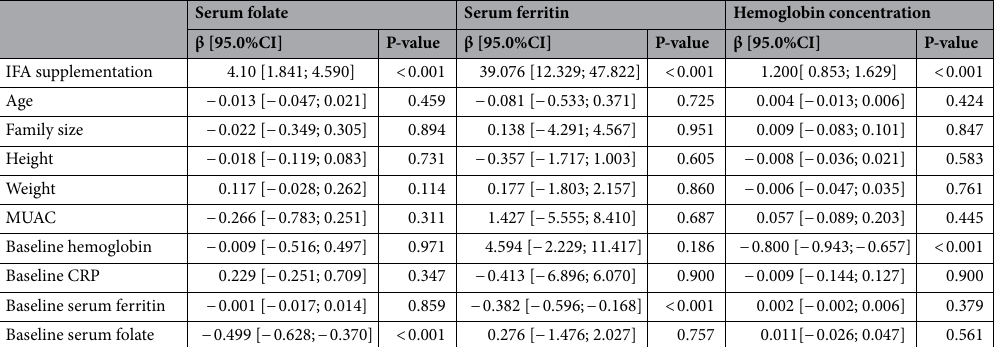
Table 4. Multiple linear regression for the association between WIFAS and serum ferritin, serum folate and hemoglobin concentration. Results are from multiple linear regression; ß = Unstandardized Coefficients; The maximum variance inflation factor (VIF) for serum ferritin status was 6.045, 5.984 for hemoglobin concentration and serum folate,